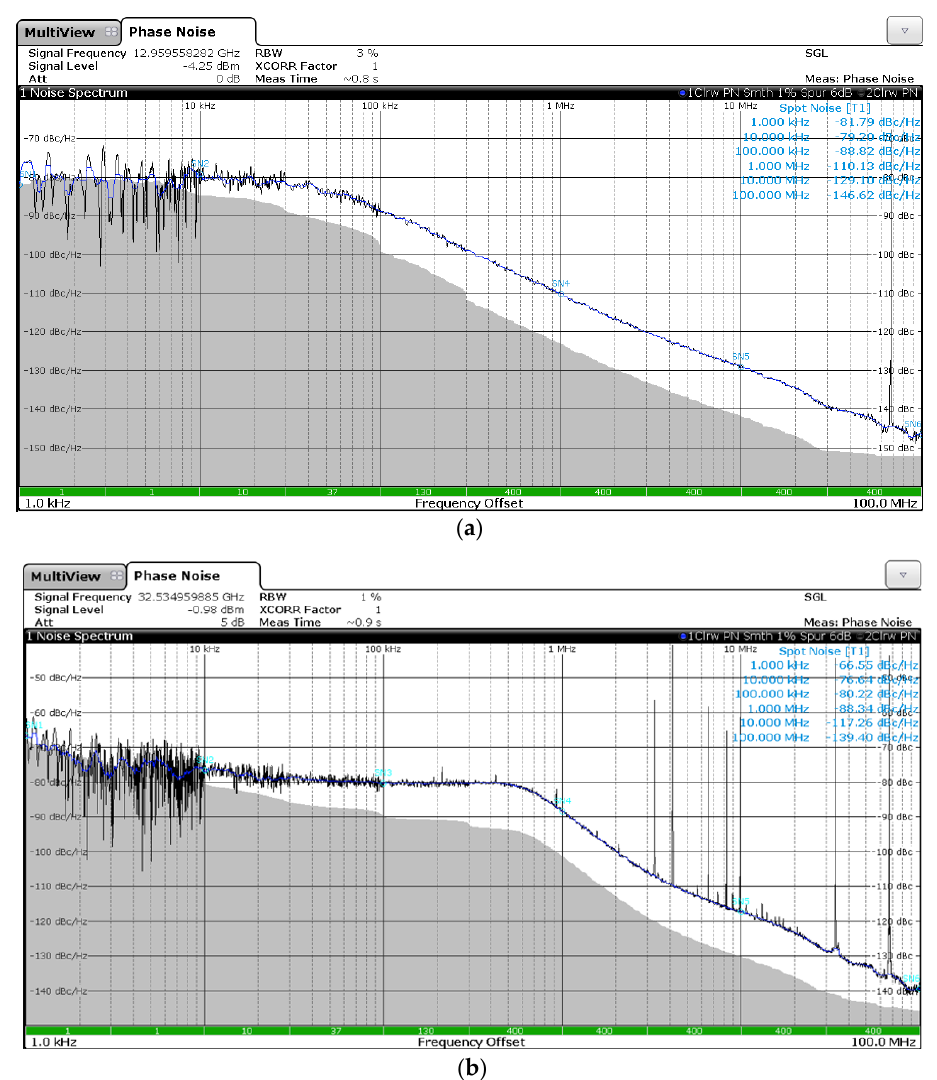
Figure 10. Measured results for the dual-loop dual-output frequency synthesizer: ( a ) at 12.96 GHz for Output1; ( b ) at 32.535 GHz for Output2.